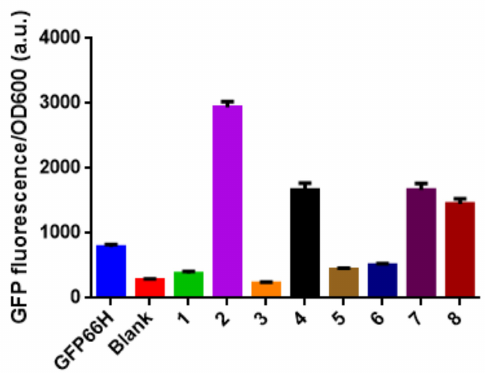
Figure 6. Relative fluorescence intensity of eGFP after incorporation of keto acids #1-#8 combined with